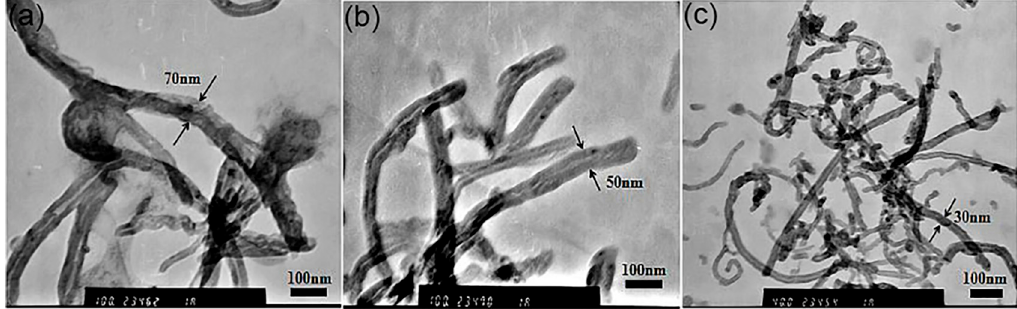
Figure 8. Transmission electron microscopy (TEM) images of drug-loaded MPEG-PDLLA/c-MWCNT nanocomposites obtained at different mass ratios of c-MWCNTs (tube diameter >30 nm, length 0.5~2 μ m) to MPEG-PDLLA: ( a ) 0.2:1; ( b ) 0.3:1 and ( c ) 1:0.